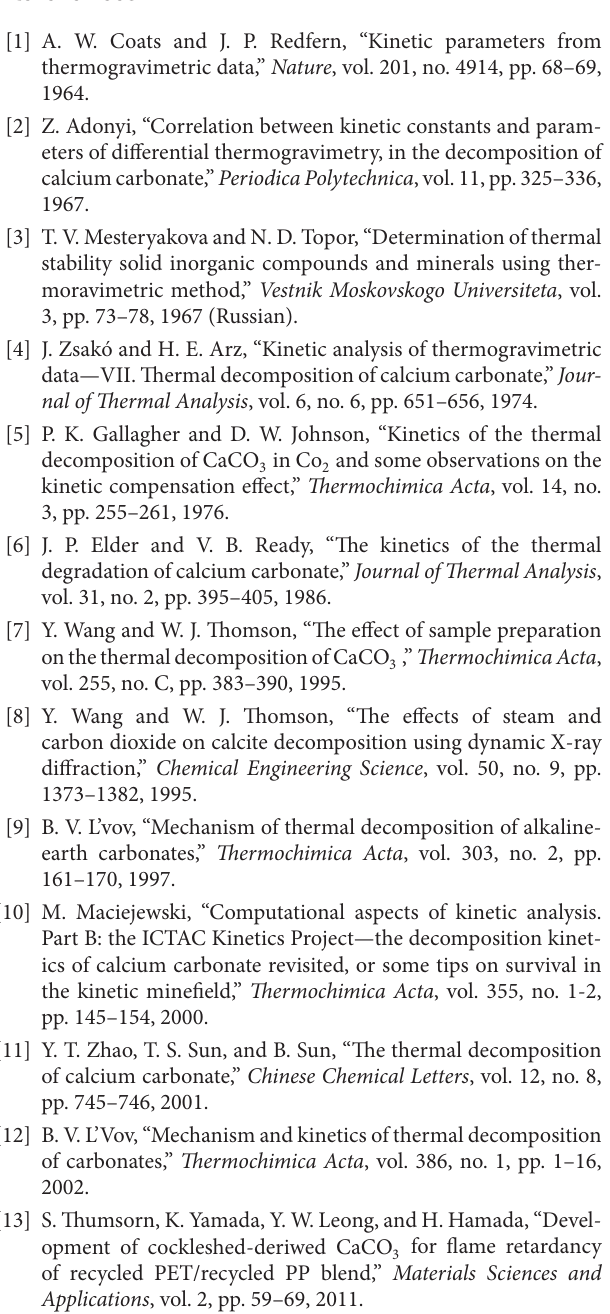
) using Ozawa-Flynn-Wall and Kissinger-Akahira- 𝛼𝛼